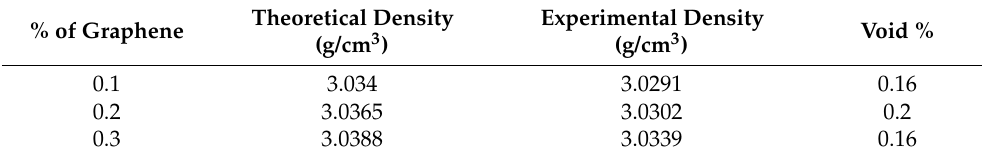
Figure 2. Density plot. Table 4. Void percentage of the